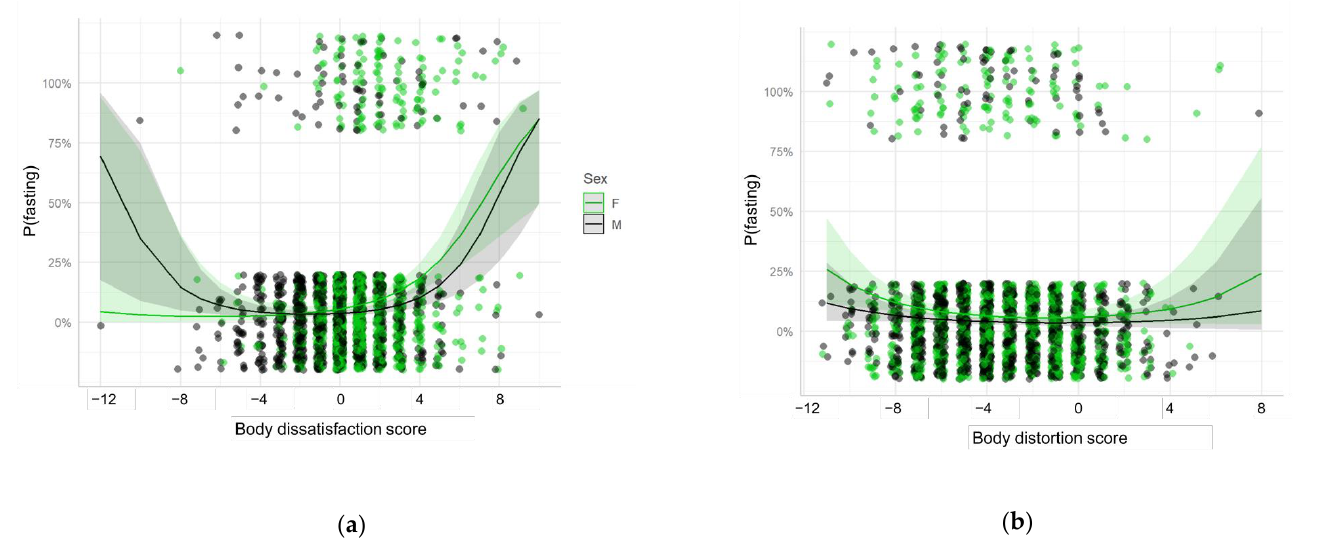
Figure 4. Random-intercept mixed effects logistic regression model for the presence of fasting as a function of ( a ) Body dissatisfaction score; ( b ) Body distortion score; and their interaction with sex. Each point represents a participant, the lines represent the fitted model and the shades represent the 95% confidence interval. The points are slightly jittered in order to avoid overplotting. F: Female; M: